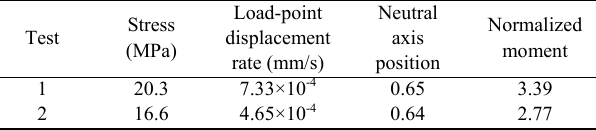
Table 1 Four-point flexure measurements obtained at two different